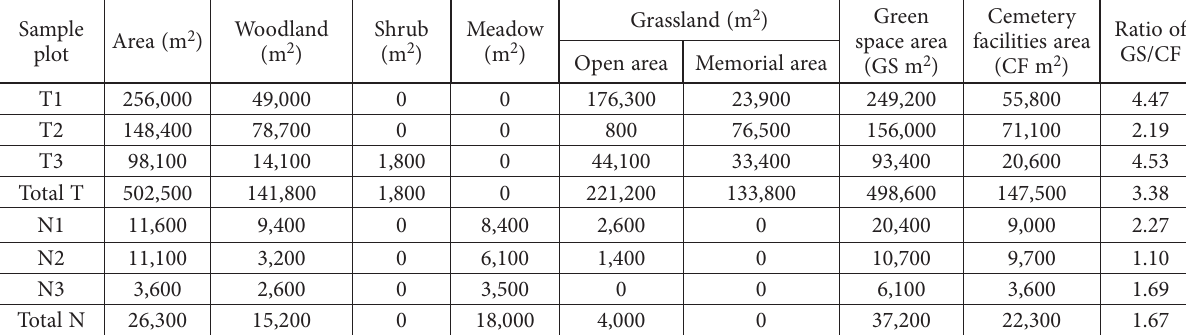
Figure 3. Plant layer distribution at the study sites (EDINA, 2018) Table 1. Basic information of each plant layer in the